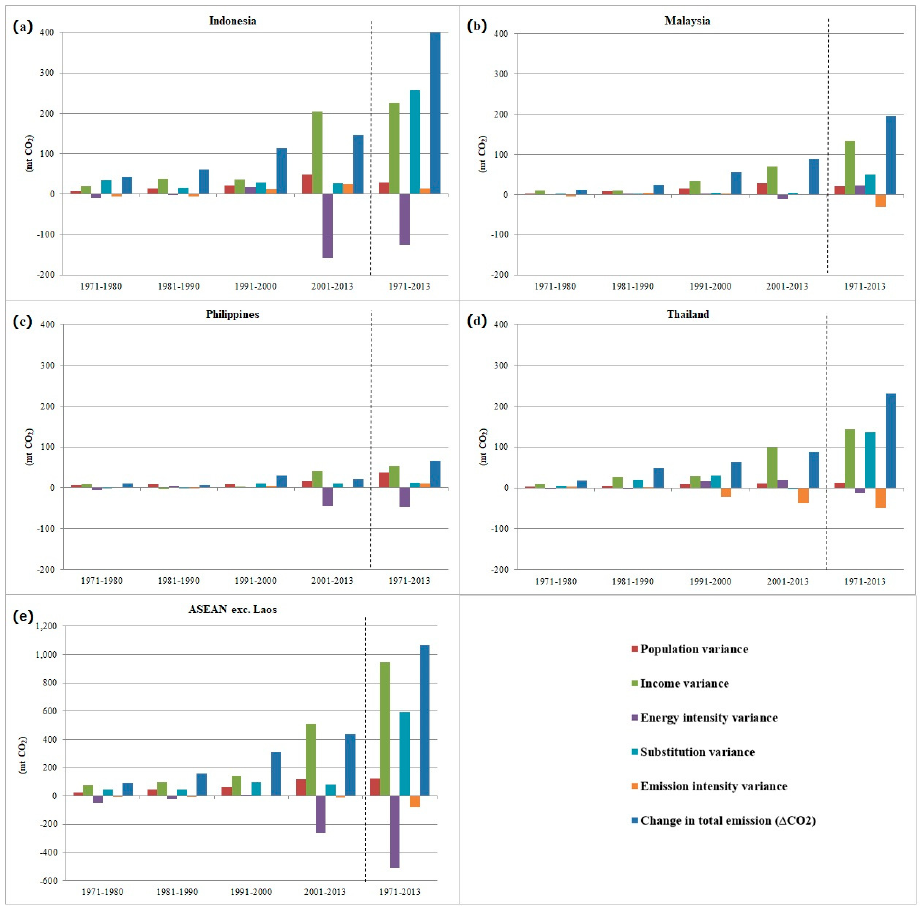
Figure A1. Decomposition results of total CO 2 emissions in Indonesia, Malaysia, Philippines, Thailand, and ASEAN.